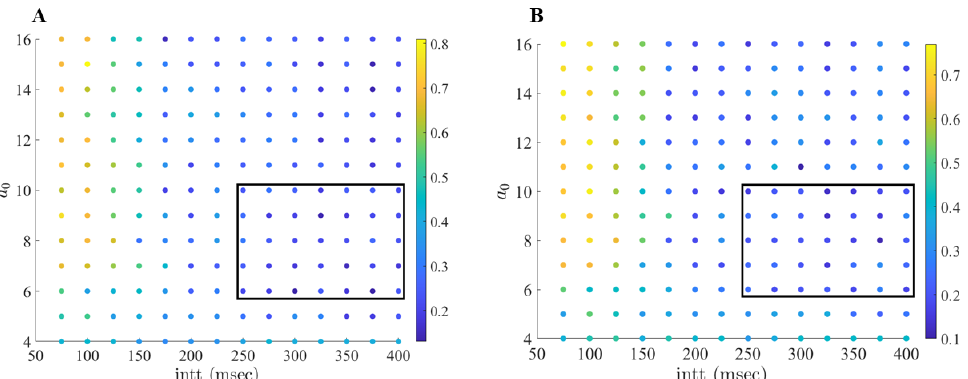
Figure 13. ( A ) Error index values (color coded) for the first TC cell, TC 1 over a range of interspike threshold parameter values intt (75 ms to 400 ms, with increment 25 ms) and a 0 —stimulation strength (4 to 16, with increment 1). ( B ) Error index values for the second TC cell, TC 2 over a range of values intt (75 to 400 ms, increment 25 ms) and a 0 (4 to 16, with increment 1). The favorable region of ( intt , a ) pairs is shown in the black 0